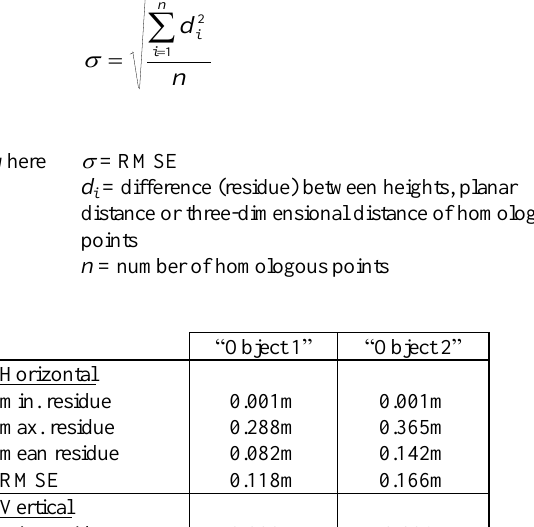
Figure 6. Upper: part of modelled facade. Lower: Distance differences between modelled plane of facade and scanning